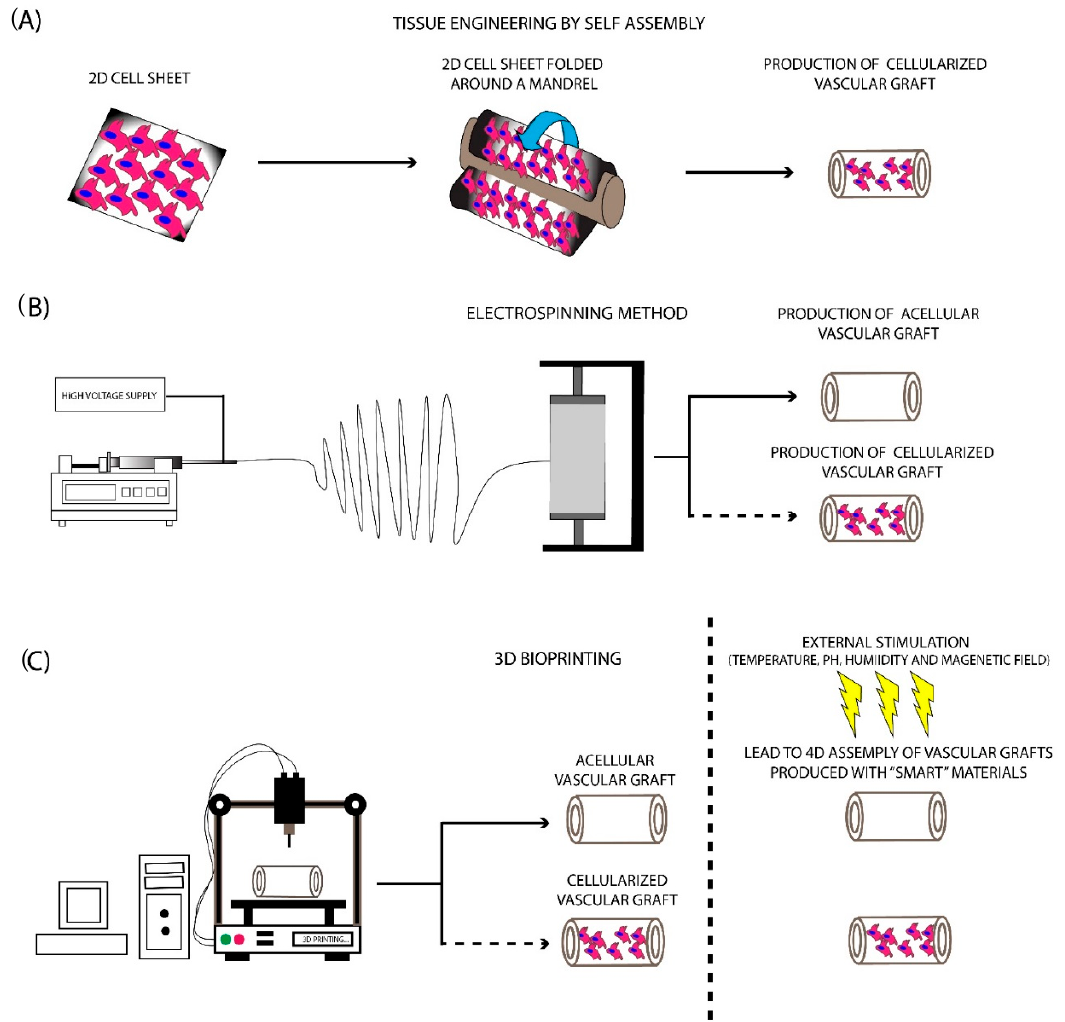
Figure 3. Fabrication methods for the production of SDVGs. ( A ) Production of SDVGs with the originally proposed method of L’Heureux et al. In this method, the production of SDVGs was relied on the self-assembly of cell sheets using a tubular mandrel. ( B ) Production of SDVGs with the electrospinning method. This methodology can produce complicated extracellular matrices (ECMs). In addition, combination with cellular populations can lead to the development of cellularized structures. ( C ) Production of SDVGs with the bioprinting method. Bioprinting offers the potential for the production of either acellular or cellularized complicated structures. Moreover, when used “smart” materials in the production process, the final product can assembly on the desired structure upon external stimulation (e.g., temperature, pH, humidity, and magnetic